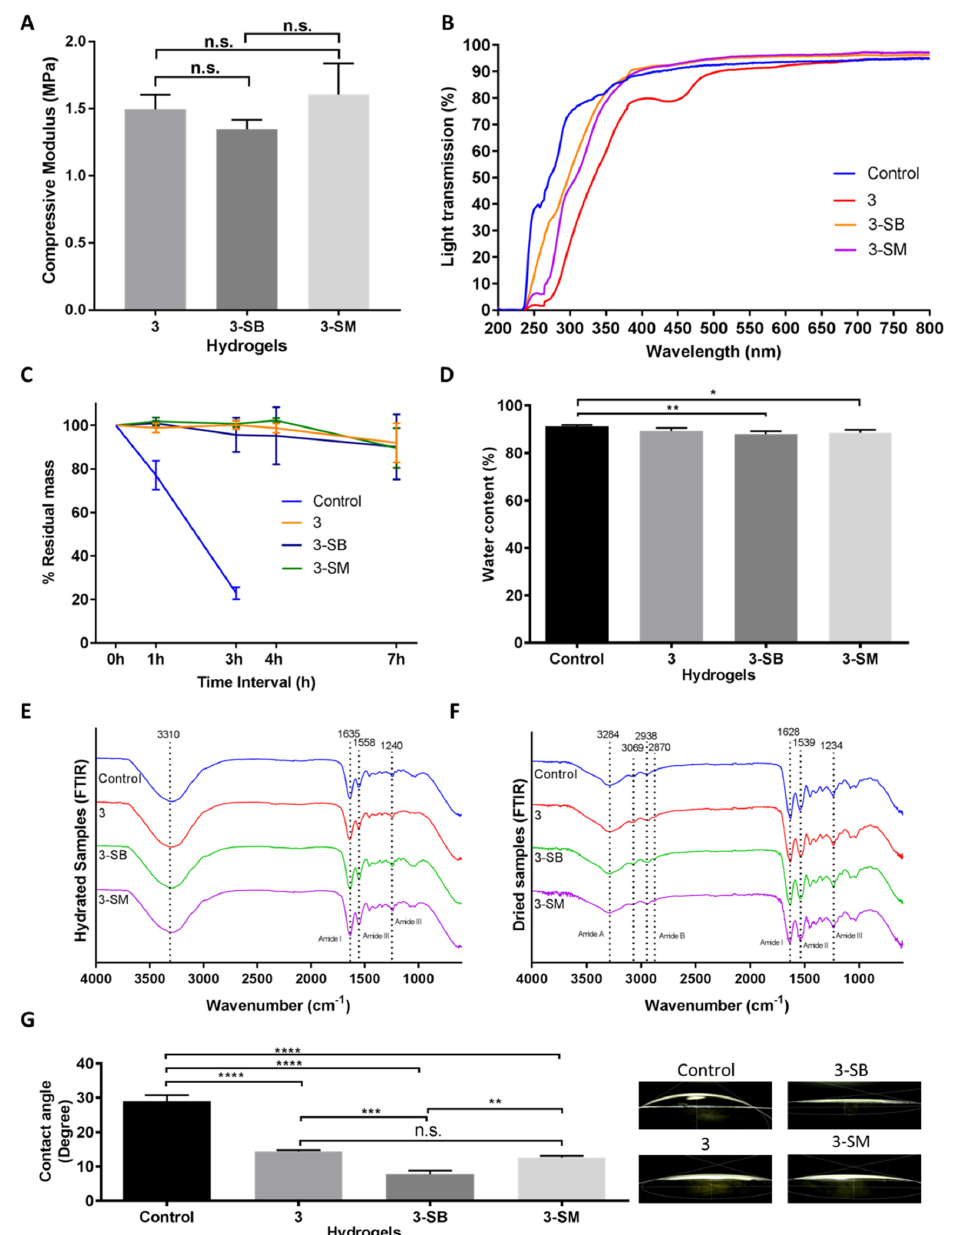
Figure 3. Mechanical and functional assessment of the collagen hydrogels, comparing the control (EDC/NHS) with post-formulation GTA-treatment (PFGT) 3 hydrogels before and after post-crosslinked chemical treatment. Sodium metabisulfite treated and Sodium borohydride treated hydrogels were abbreviated as 3-SM and 3-SB hydrogel, respectively. ( A ) Compressive modulus was measured to evaluate the mechanical properties of the 3 hydrogels. ( B ) Optical evaluation of the hydrogels was carried out based on the analysis of light transmission. ( C ) Collagenase study was performed and residual mass (presented against time in hours (h)) of the hydrogels were calculated. ( D ) Water content measurement (%) among the hydrogels compared with control hydrogels. FTIR spectra of hydrated ( E ) and dried ( F ) hydrogel samples. ( G ) Representative micrographs of water contact angles of different hydrogels with the corresponding contact angle measurement. For all panels, quantitative results were reported as the mean ± S.D. from three independent samples and results compared between groups. n.s., *, **, ***, and **** represent p greater than 0.05, p < 0.05, p < 0.01, p < 0.001, and p < 0.0001, respectively.